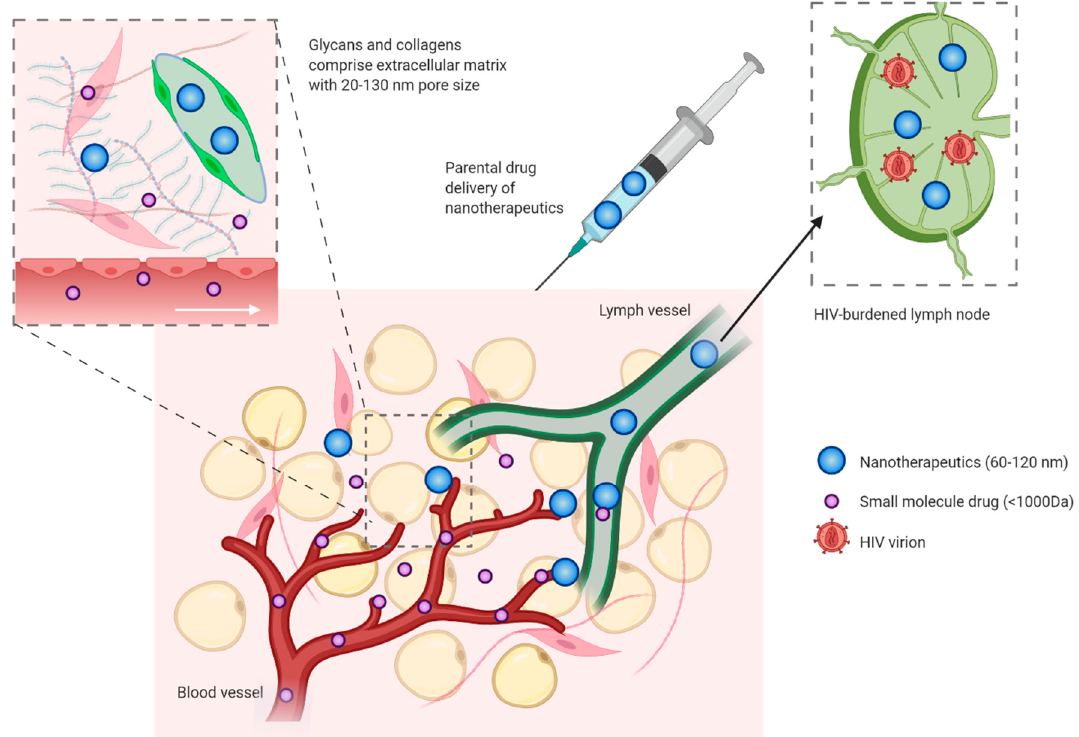
Figure 2. Interstitial space draining of nanotherapeutics. After subcutaneous injection of the nanotherapeutic particles, they will be dispersed in the interstitial space. This space is comprised of cells and an extracellular matrix, composed of glycans and collagens that will allow free passage of smaller molecules [63]. Based on size and physicochemical properties, such as lipophilicity, nanoparticles can either be removed via the draining venules or the peripheral lymphatic capillaries. Small molecule drugs are preferentially cleared via the draining blood vessels [56,109]. Created with Biorender.com.